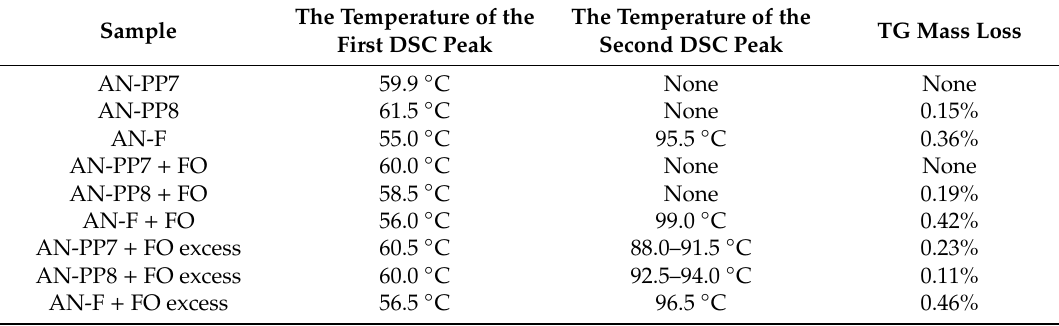
Di ff erential scanning calorimetry (DSC) and thermogravimetry (TG) results of AN-based